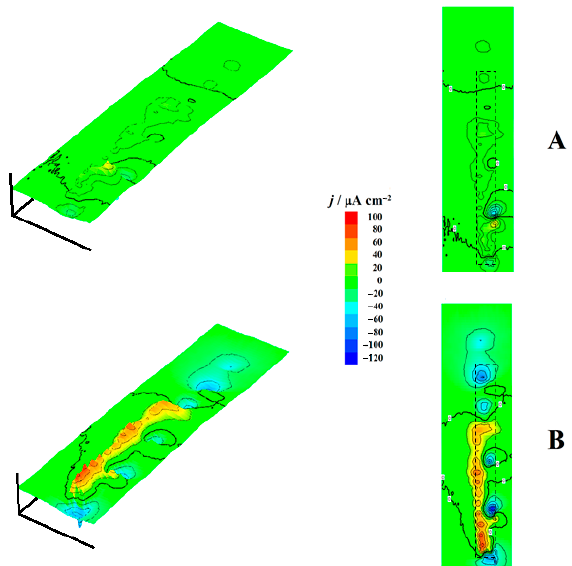
Figure 6. SVET maps recorded for the cut edge of a galvanized steel sample after removing the organic coatings at each side (i.e., corresponding to sketch #2 in Figure 1C). The images were recorded after ( A ) 15 and ( B ) 165 min immersion in 1 mM NaCl solution. The approximate location of the specimen is indicated by the drawn rectangles. The images represent, in X and Y directions, 1580 μ m × 6000 μ m. Values of Z axis: Ionic current, μ A cm –2 . Mean probe-substrate distance: 100 μ m.